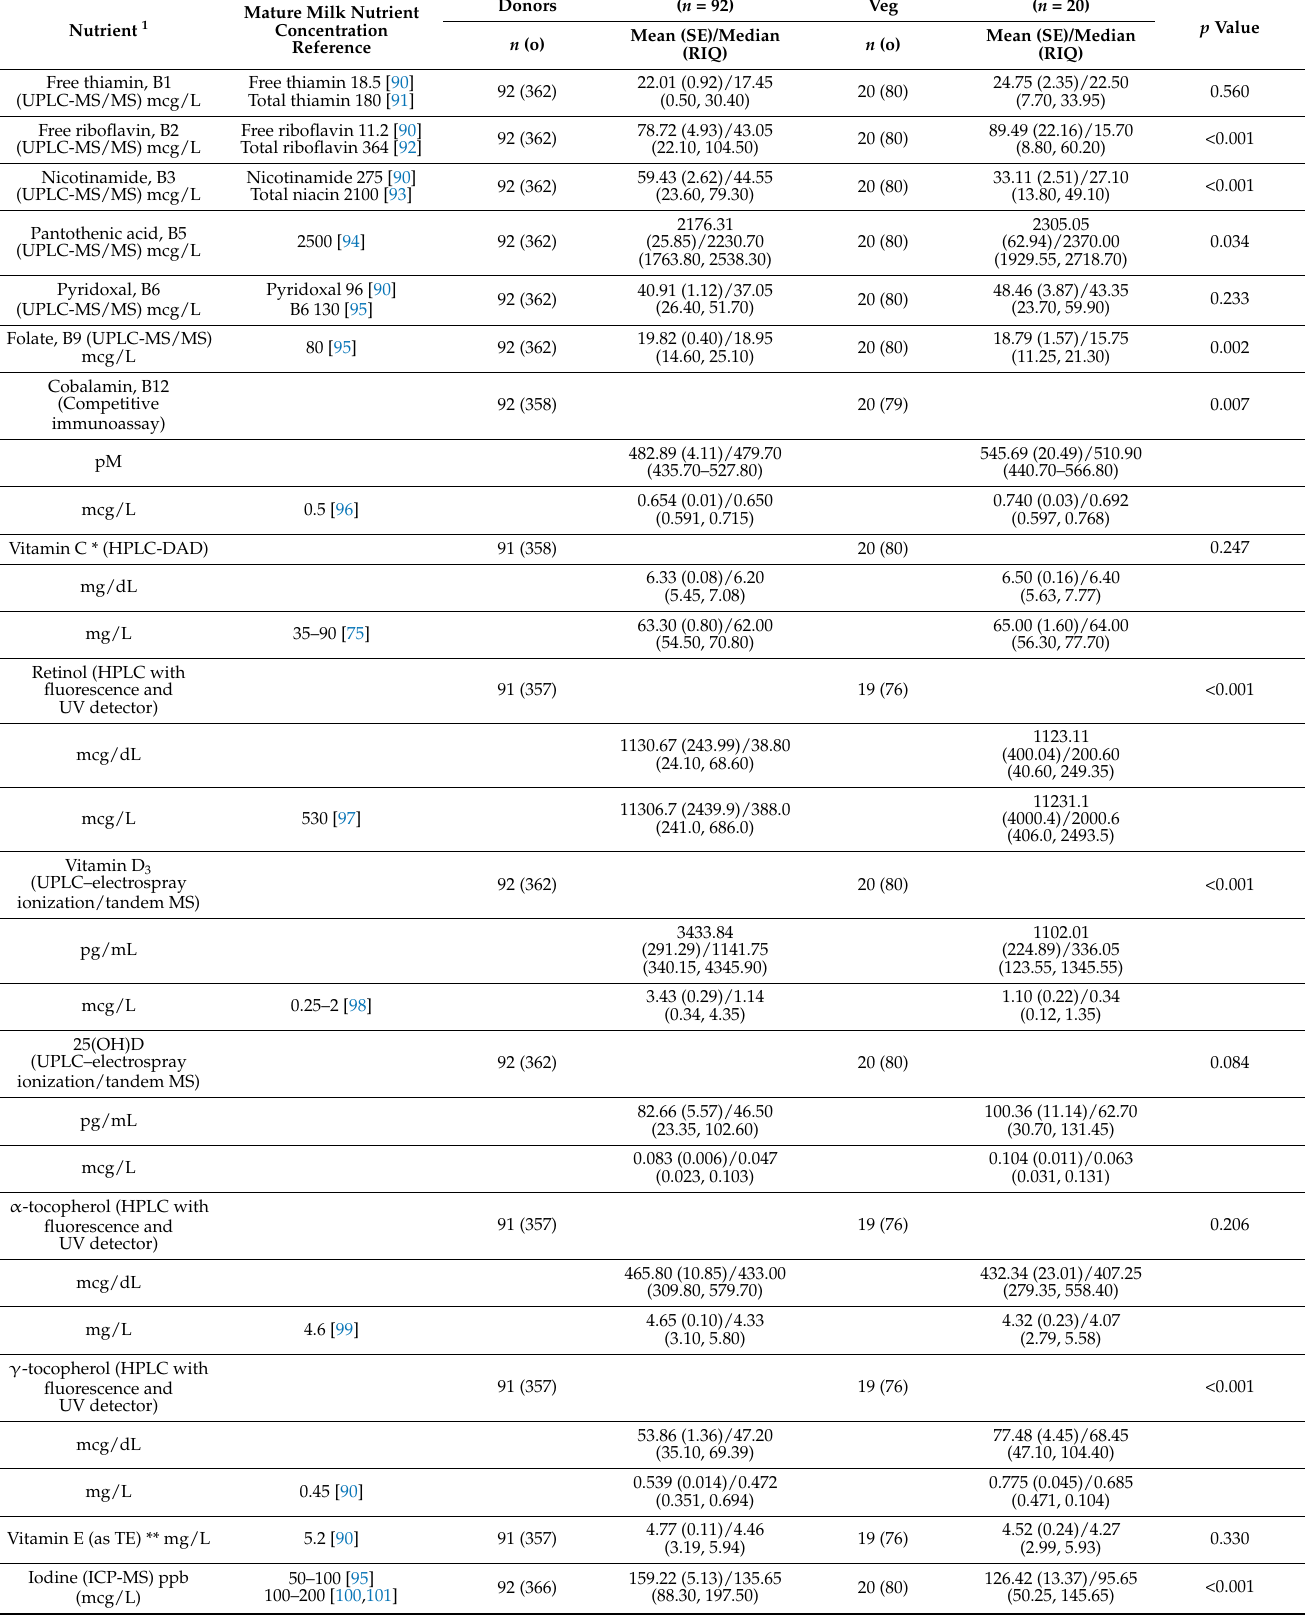
Table 13. Vitamins and minerals in milk of omnivore human milk donors with full-term infants (Donors) and vegetarian/vegan mothers